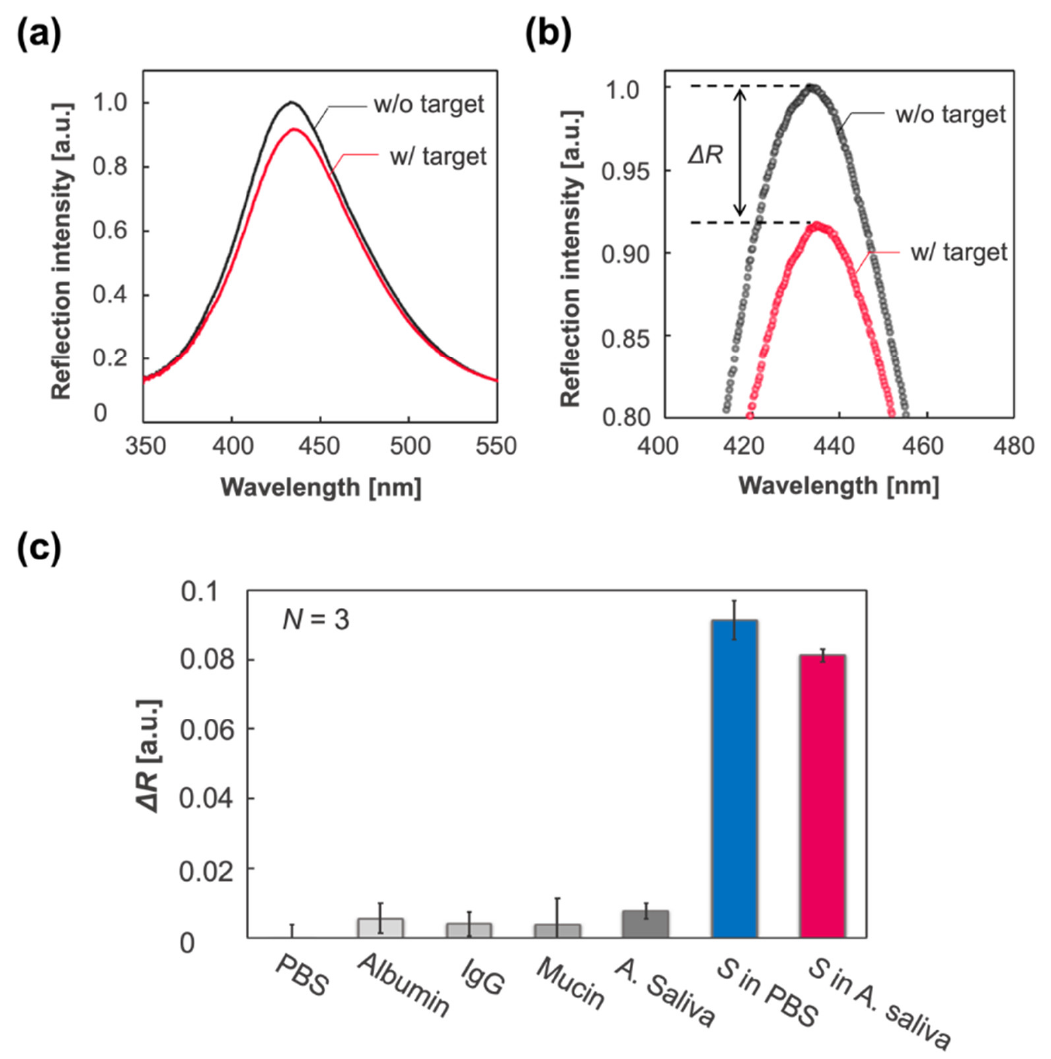
Figure 4. Label-free specific detection of SARS-CoV-2 spike proteins ( S ). ( a ) Reflection spectrum of the IPCF before (F-IPCF, black) and after (Target, magenta) incubation in A. saliva sample solution containing spike proteins (1 ng/mL). ( b ) Enlarged spectra around the peaks. The label-free detection of the target ( S ) was based on the decrease in reflection intensity, ∆ R . ( c ) Selectivity for the spike proteins. From left to right: PBS (pH 7.4), albumin (200 µ g/mL in PBS), IgG (20 µ g/mL in PBS), mucin (20 mg/mL in PBS), A. saliva containing albumin, IgG, and mucin in PBS (grey scale bars), spike-protein-containing PBS (blue bar), and A. saliva (magenta bar).